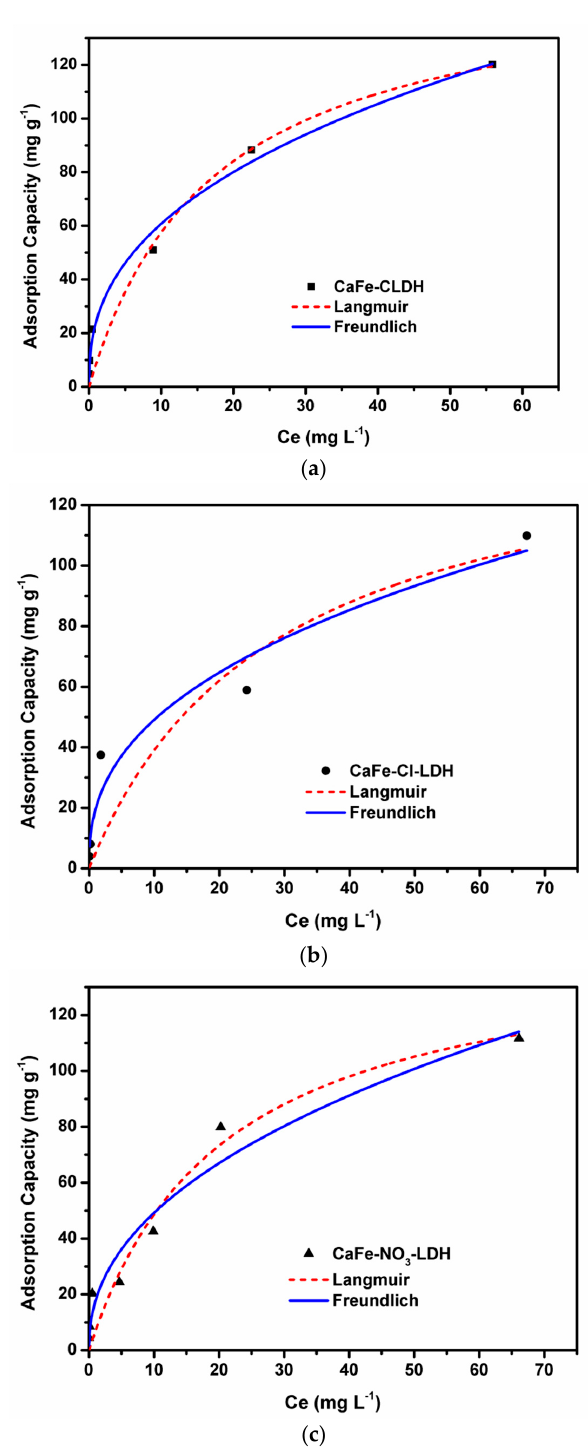
Figure 3. ( a ) Isothermal study of adsorption of arsenic with CaFe-CLDH. ( b ) Isothermal study of adsorption of arsenic with CaFe-Cl-LDH. ( c ) Isothermal study of adsorption of arsenic with CaFe-NO 3 -LDH (Experimental condition: initial concentration range of arsenate was from 1 mg · L − 1 to 100 mg · L − 1 , materials dosage = 0.2 g · L − 1 , initial pH =